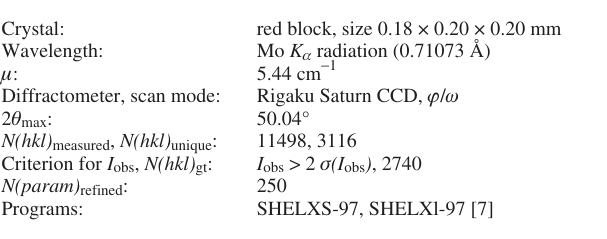
Table 1. Data collection and handling.